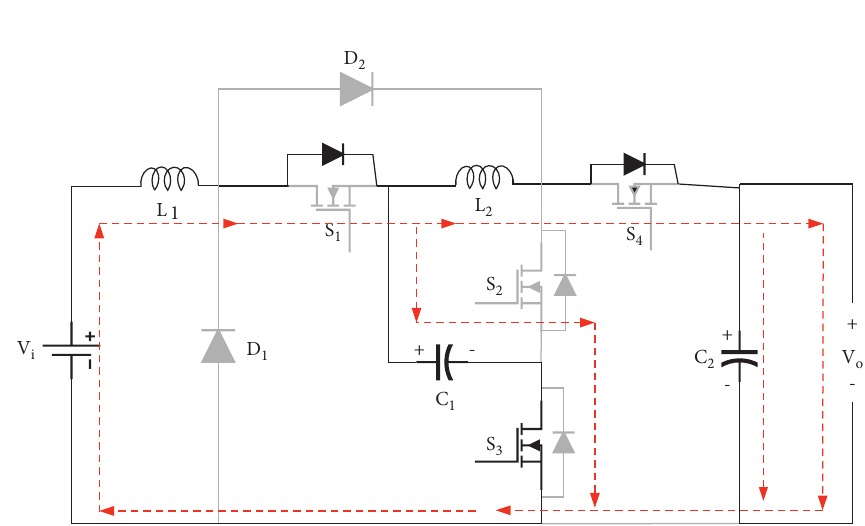
Figure 4: Converters’ boost mode operation in mode 2.